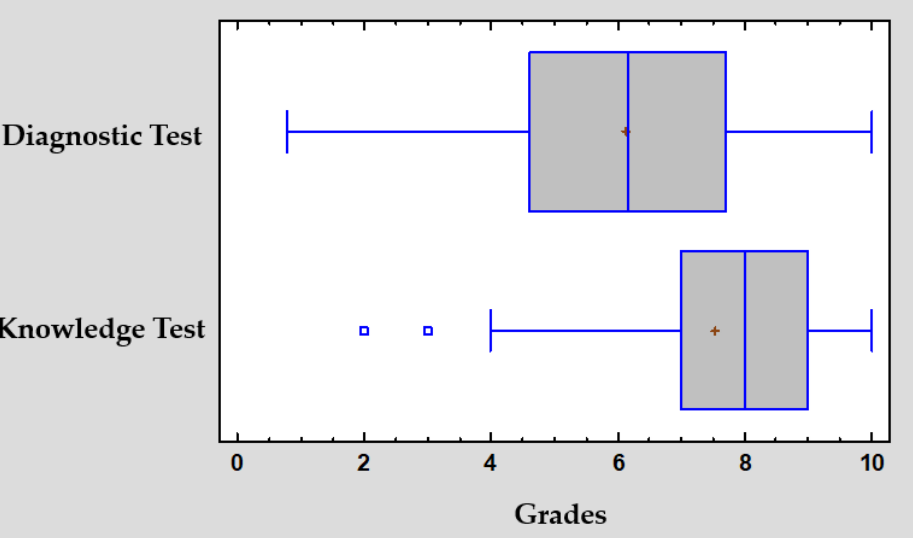
Figure 10. Box-and- whisker diagram for the students’ grades in the Diagnostic and Knowledge